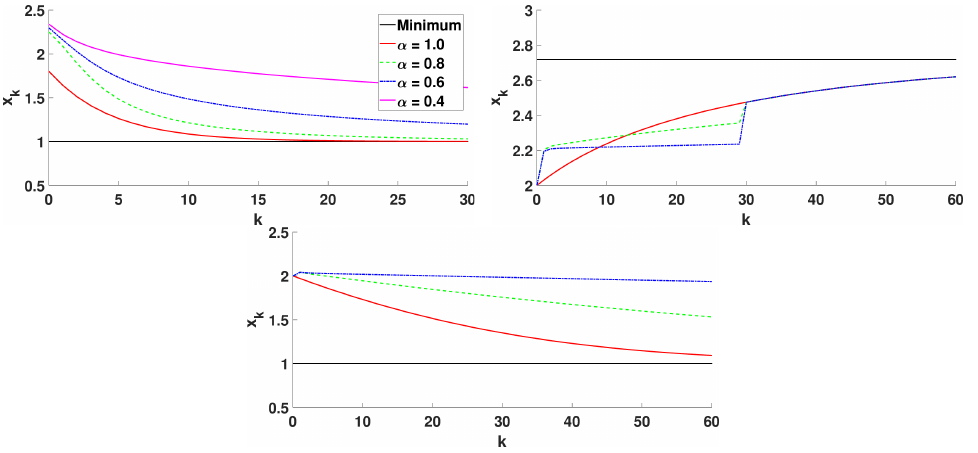
Figure 1. Algorithm 1 for different orders of differentiation, α